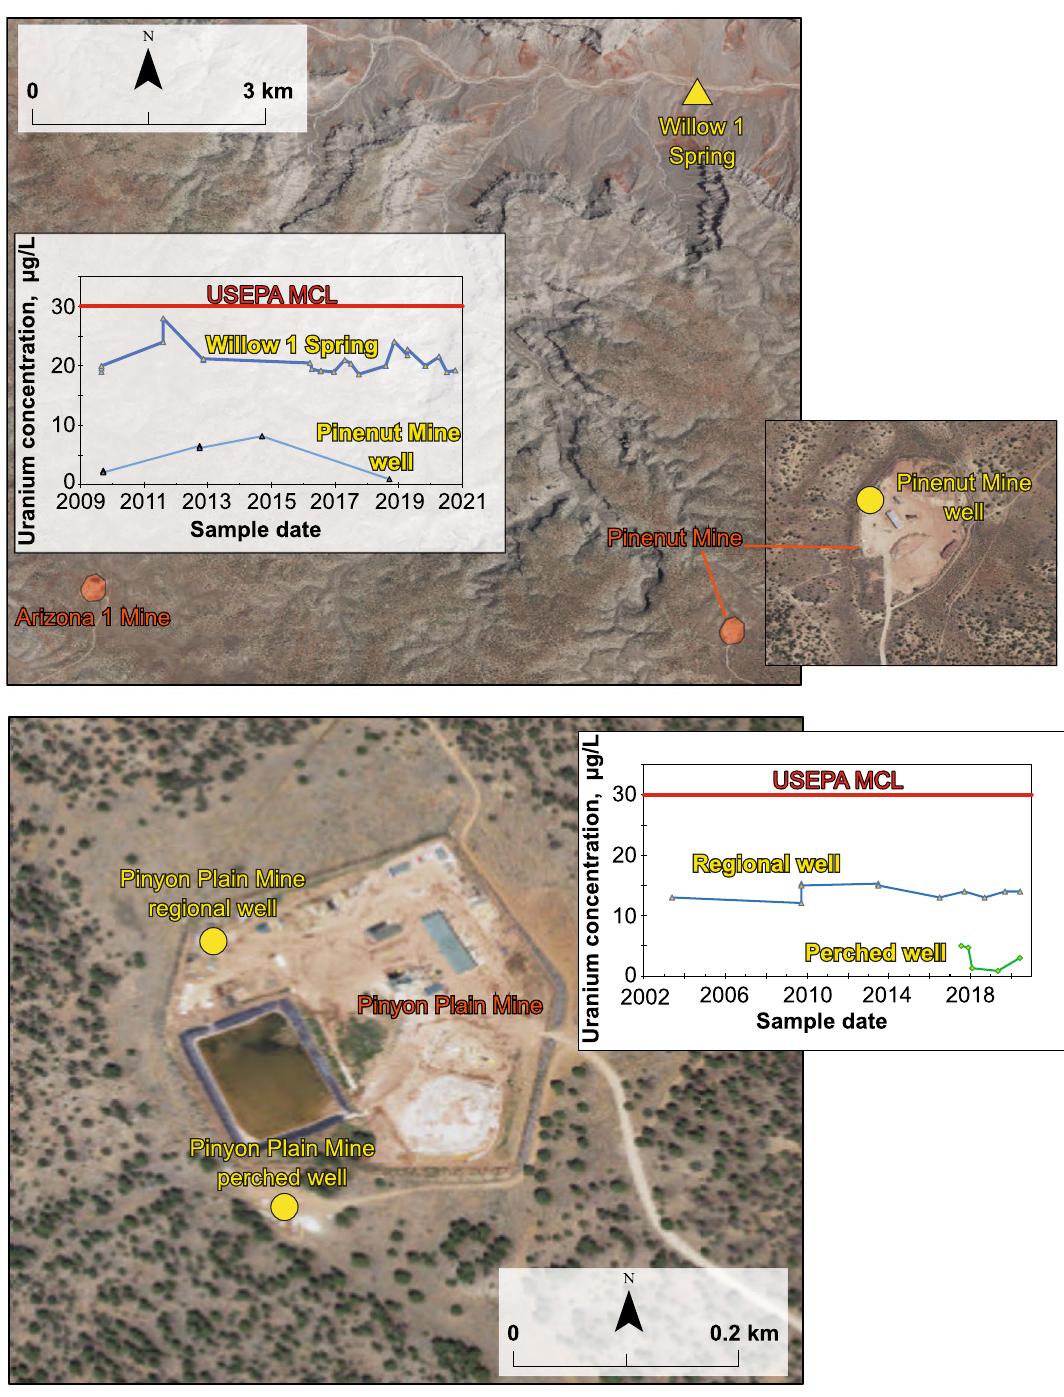
Figure 7. Groundwater sites monitored by USGS at and near breccia-pipe uranium mining locations in the Grand Canyon region including the Pinenut Mine (top panel) and the Pinyon Plain Mine (bottom panel). Map created in Esri ArcMap 10.8.1 (https:// www. esri. com/). Basemap image from the public domain USGS National Map 11